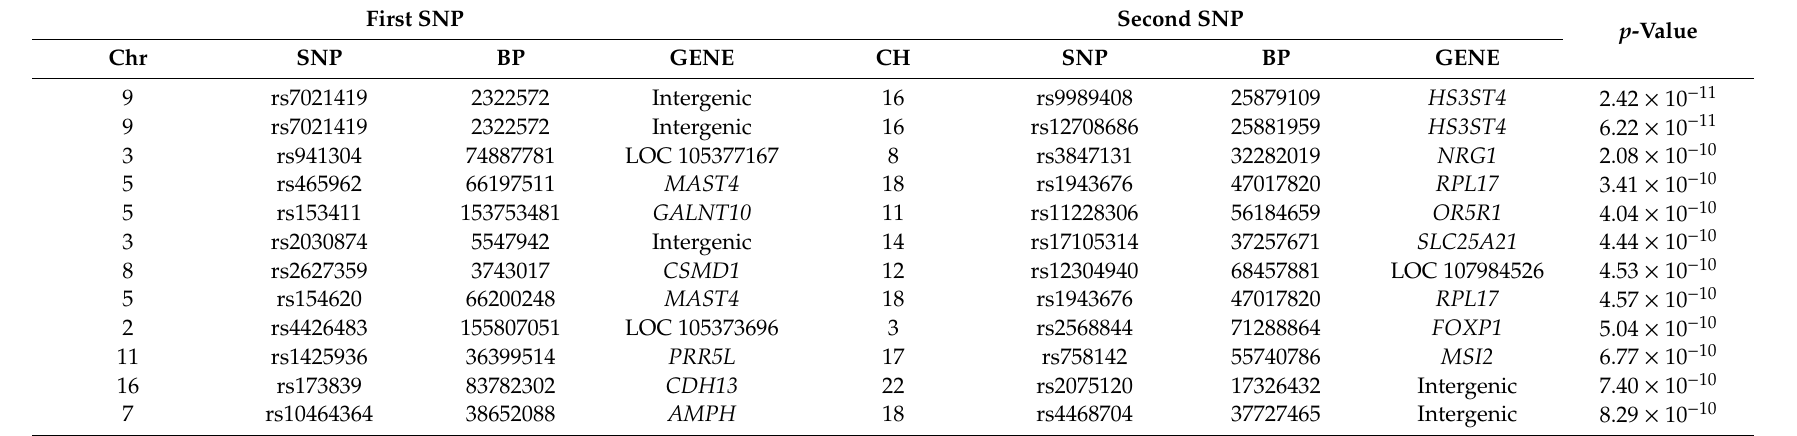
Table 3. Top gene-gene interactions, with corresponding chromosome (Chr), single-nucleotide polymorphism (SNP), base position (BP), and gene in the WNV dataset. None of the interactions passed the Bonferroni-corrected p -value of 5 × 10 − 14 . Gene acronyms, in order of appearance: Heparan